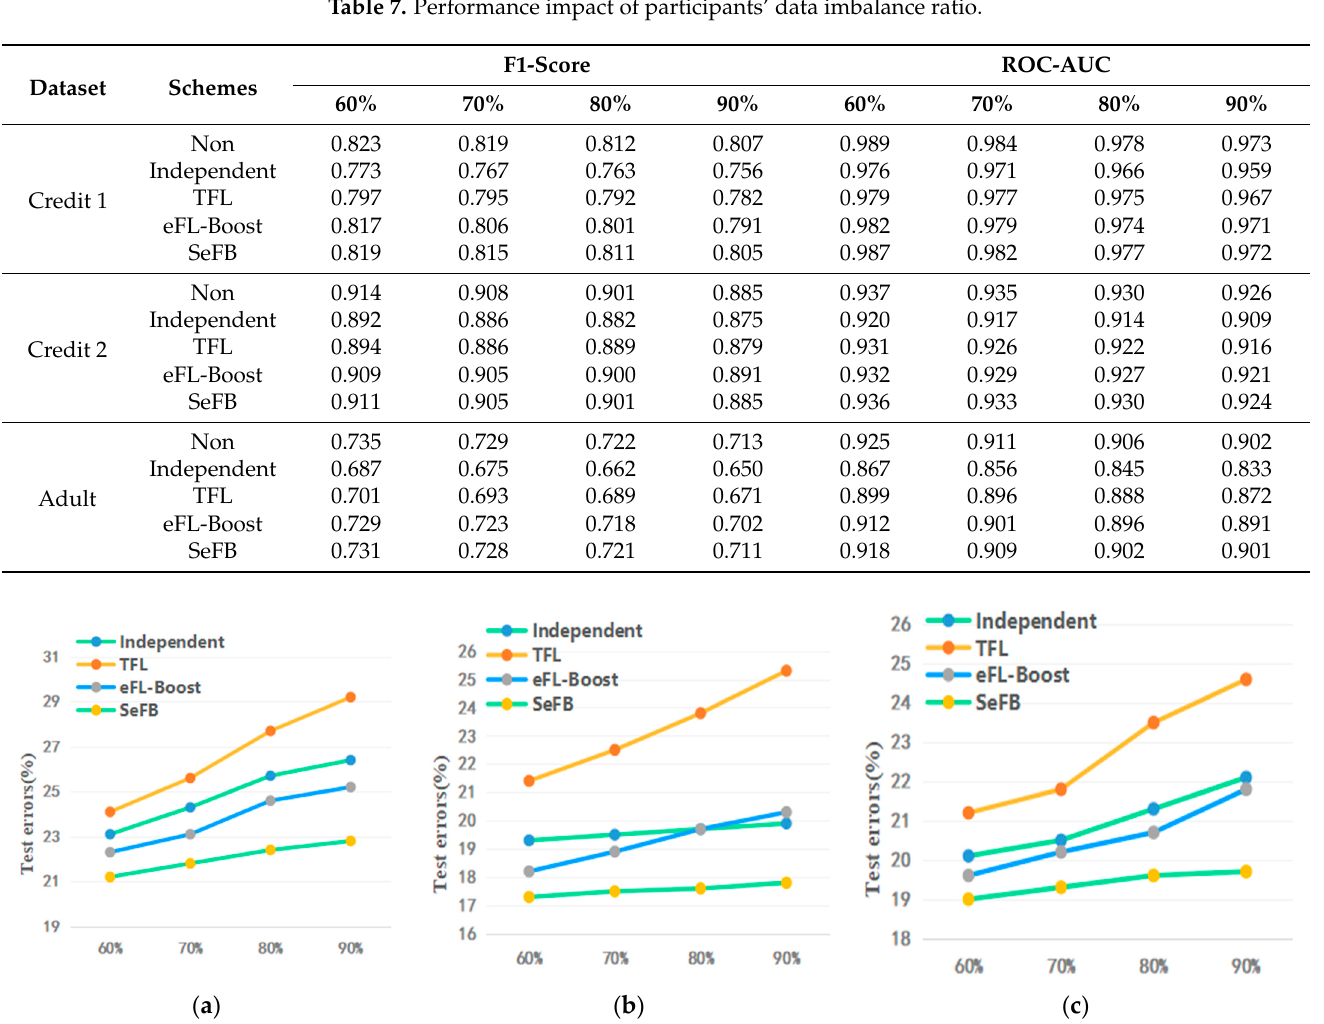
Table 7. Performance impact of participants’ data imbalance ratio.